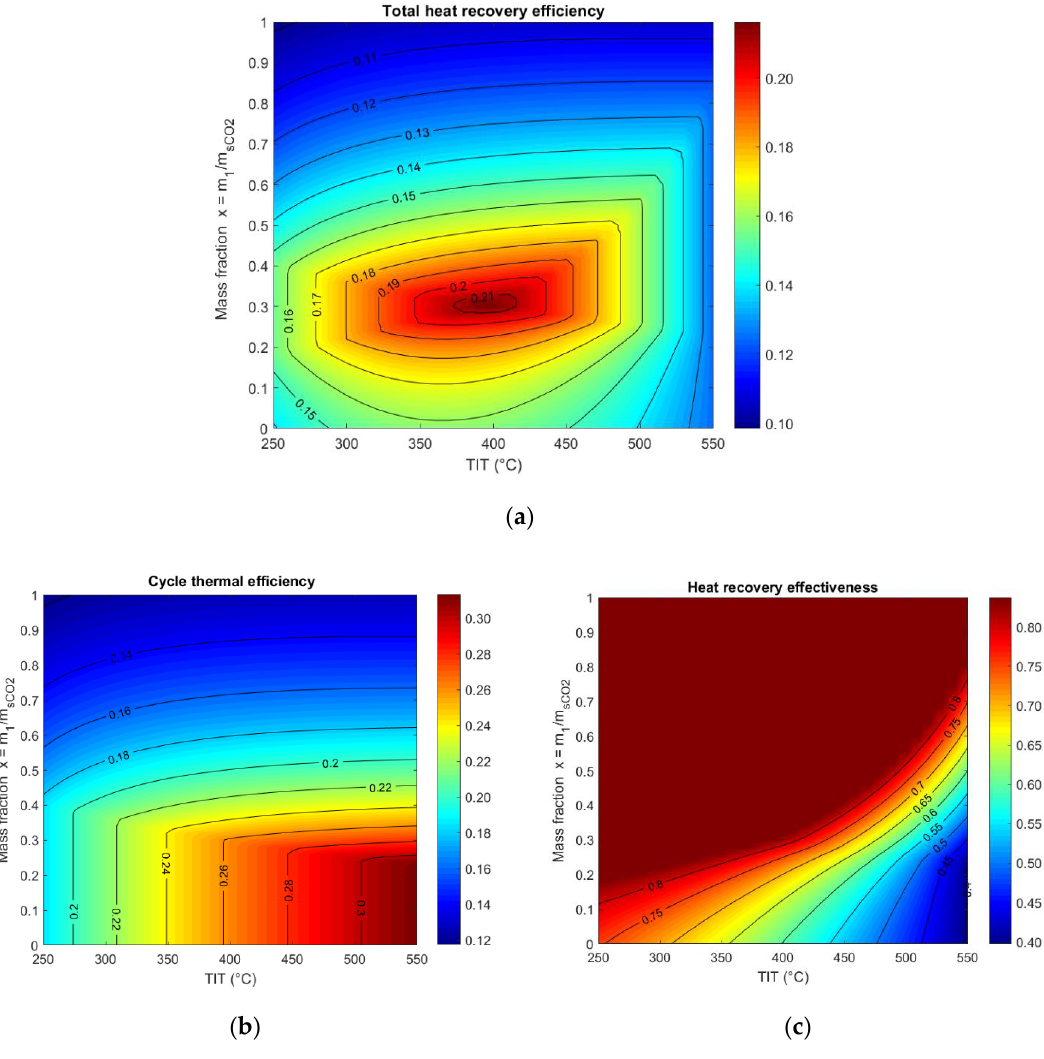
Figure 10. Variation of the performance metrics with TIT and x for the partial heating cycle: ( a ) Total heat recovery efficiency; ( b ) Cycle thermal efficiency; ( c ) Heat recovery effectiveness.